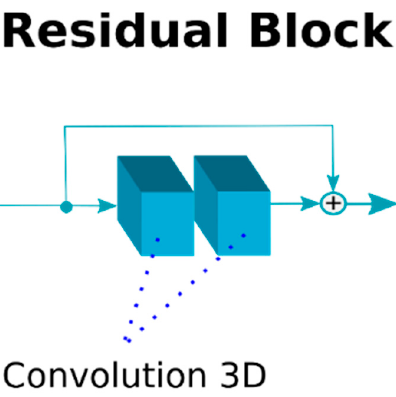
Figure 4. Schematic representation of the Franken-net architecture. Our implementation in TensorFlow processes 3D cubes of the MR T1-weighted input image to generate a pseudo-CT cube with the same shape as the input.